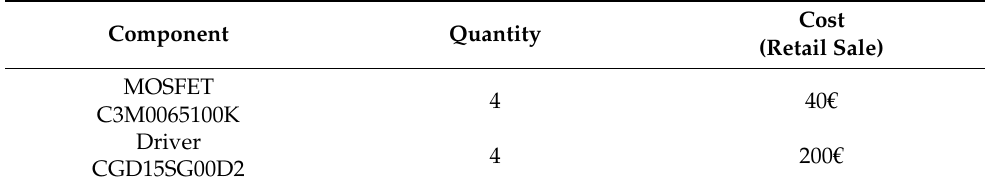
Table 3. SiC resonant inverter.